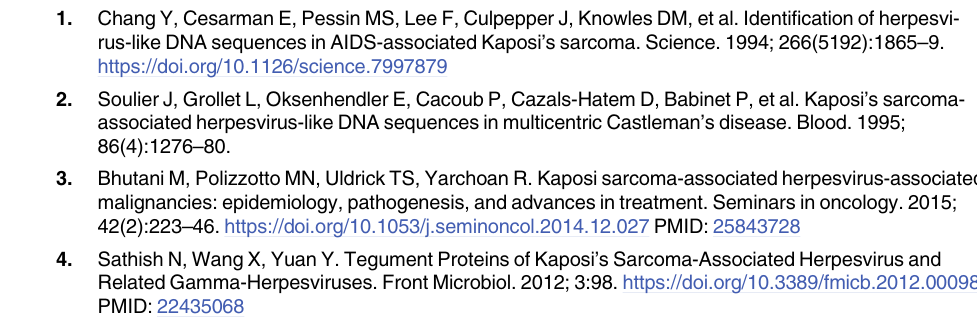
and iSLK-BAC16-RAB11FIP5 cells were induced with dox to stimulate lytic KSHV replication. Viral particles were labeled with the mouse anti-ORF65 antibody, while the trans-Golgi net- work was labeled with the rabbit anti-TGN46 antibody. FITC- and Cy3-conjugated secondary antibodies were used to visualize the labeled ORF65 and TGN46 proteins, respectively. S5 Fig. The interaction between ORF45 and five RAB11FIP family members. HEK293T cells were cotransfected with Flag-ORF45 and HA-RAB11FIP1, HA-RAB11FIP2, HA-RAB11- FIP3, HA-RAB11FIP4 or HA-RAB11FIP5. Cell lysates were immunoprecipitated with an anti- Flag antibody and were then analyzed by western blotting with the indicated